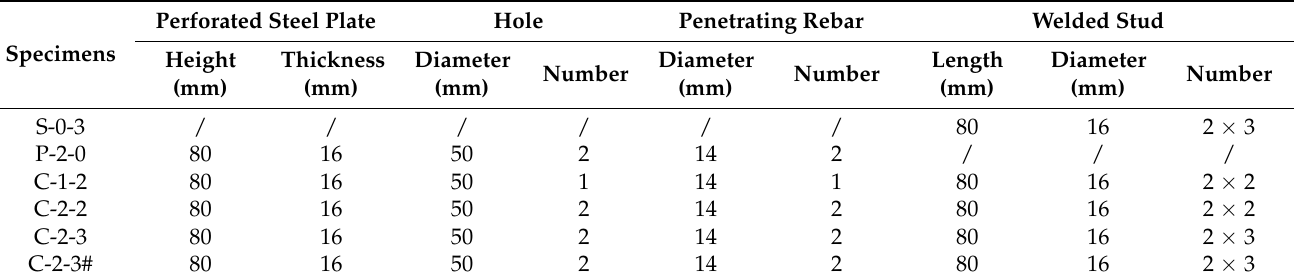
Table 1. Design parameters of the specimens.